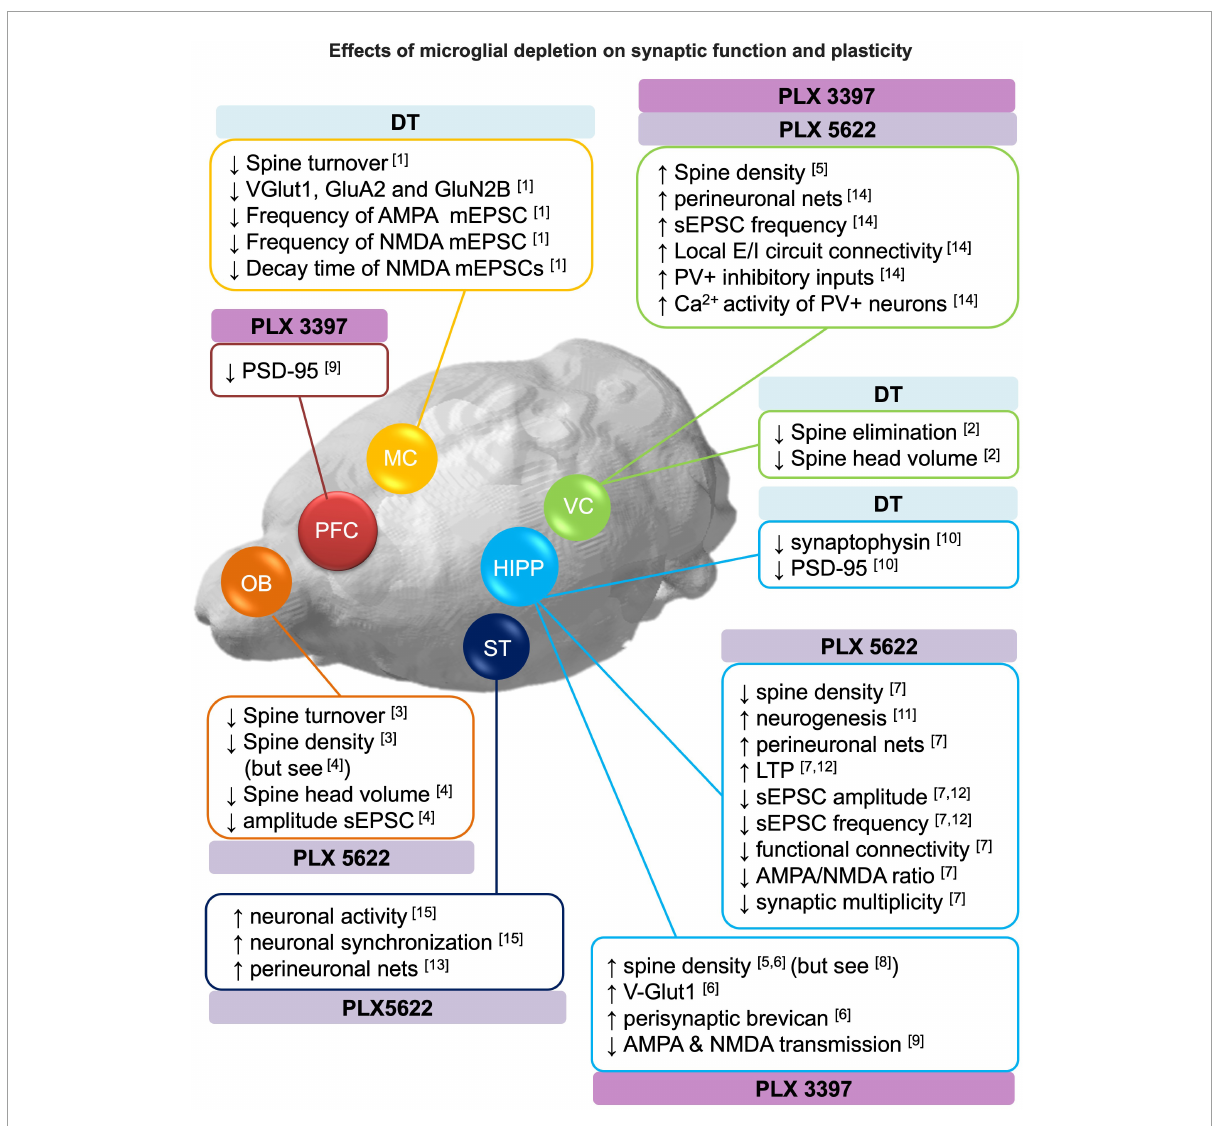
FIGURE2 Effects of microglial depletion on synaptic function and plasticity. Schematic representation of the reported effects of microglia depletion with CSF1R inhibitors (PLX3397 and PLX5622) and genetic DT-induced on dendritic spines, neurogenesis, perineuronal nets, excitatory and inhibitory (E/I) neurotransmission (see section 3 for more detail). DT: diphtheria toxin, HIPP: hippocampus, MC: motor cortex, OB: olfactory bulbs, PFC: prefrontal cortex, ST: striatum, VC: visual cortex. [1] Parkhurst et al., 2013; [2] Ma et al., 2020; [3] Reshef et al., 2014; [4] Wallace et al., 2020;